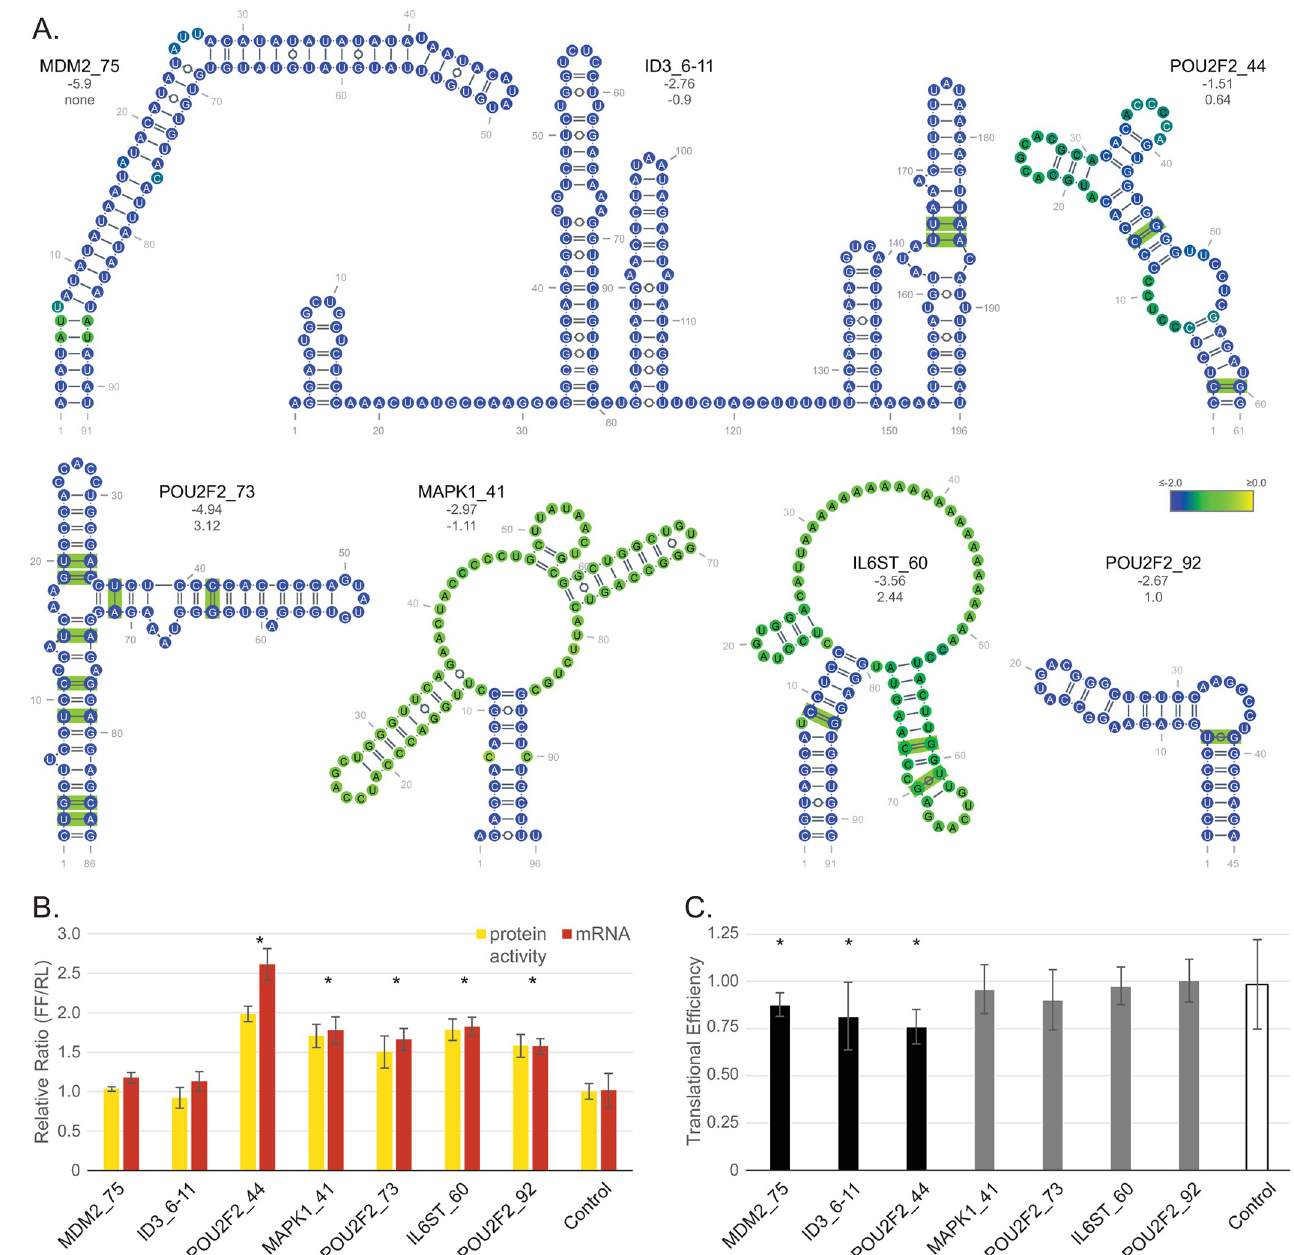
Fig 8. Reporter assay showing effects of 3 0 UTR structures on translation. (A) Secondary structures of the seven sequences cloned and tested in a dual luciferase assay. Covarying base pairs are denoted in green (R-scape). Structure average z-scores and Zcm numerics indicated below the name. Colored bases indicate the z-score average per nucleotide for all calculated windows. (B) Graph showing the results of both the dual luciferase assay (yellow; RRR; n = 5 or 6) and corresponding ratio of firefly to renilla mRNA expression (red, n = 3). (C) Graph of the translational efficiency (RRR/mRNA) using data from B. Asterisks denote a p < 0.05 by t-test to control. The structure z-score (not the average of per nucleotide windows) and the Zcm are provided under the structure names,